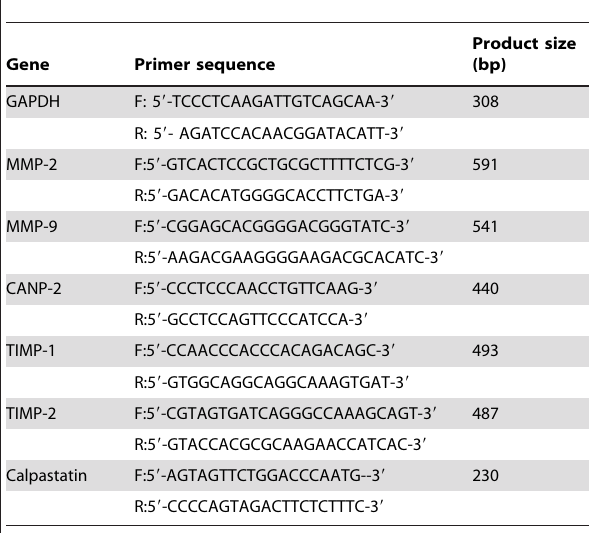
Table1. Rat primer sequences used in RT-PCR.